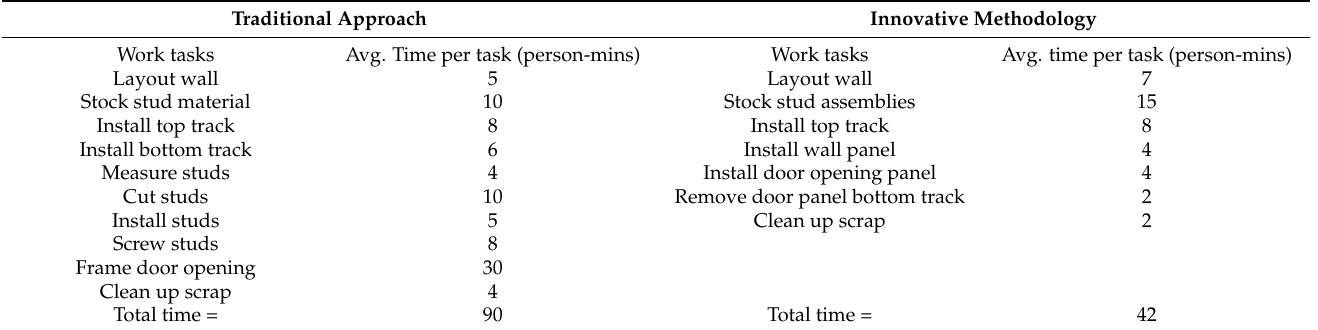
Table 1. Time comparison for onsite work tasks of traditional framing approach compared to utilization of prefabricated wall assemblies for 12 lineal feet of wall including one door opening.